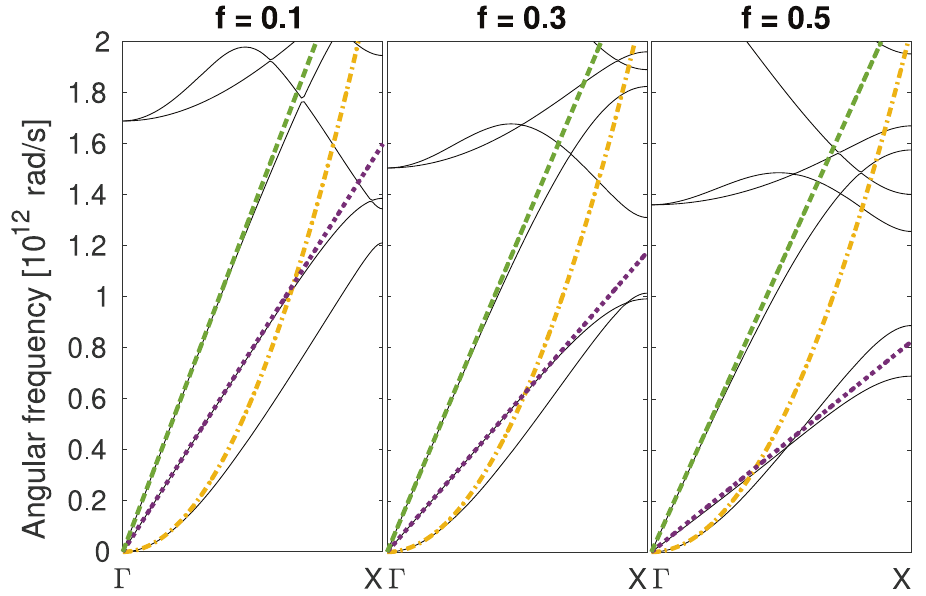
Fig. 4 Dispersion relations of the lowest modes. The EMT results for A (yellow dot-dash), S (green dash), and SH (purple dot) mode, calculated based on Eqs. (1), (2), are compared with the exact numerically calculated dispersions (black solid), for three different fi lling factors f = 0.1,0.3,0.5, in Γ - X direction. SiN parameters E = 250 GPa, ρ = 3100 kg/m 3 , ν = 0.23 and a plate thickness d = 10 nm were used, and in the exact calculation a period a = 10 a = 50 nm (Supplementary Fig. 3), and d = 300 nm, a = 50 nm (Supplementary Fig. 4).